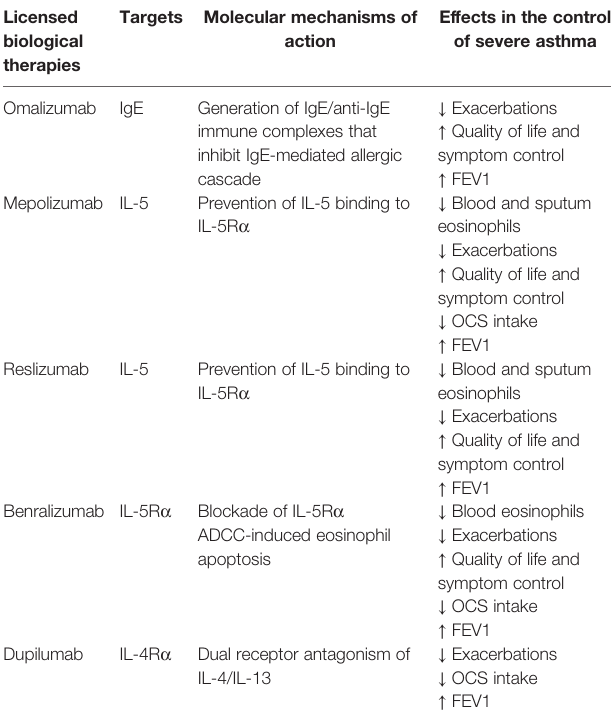
TABLE 1 | Licensed biological therapies for severe